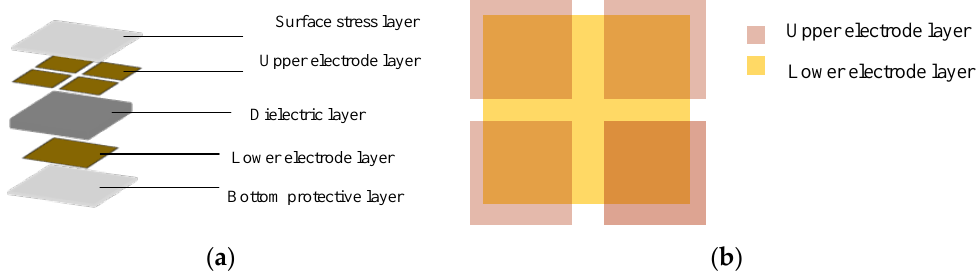
Figure 1. ( a ) Structure scheme of the proposed capacitive sensor; ( b ) projection relationship of upper and lower electrode layers.